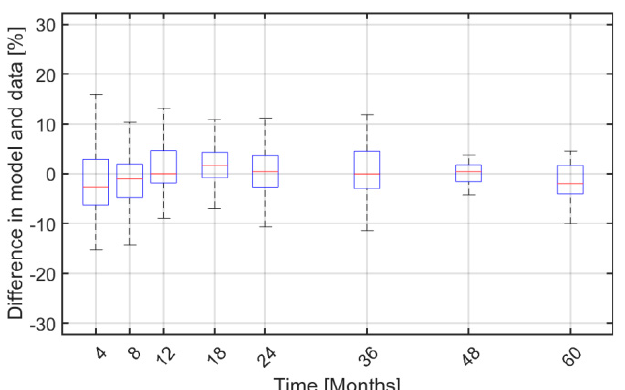
Figure 6. Boxplots of the absolute difference between the personalized JAK2 V617F allele burden data and model predictions over time—i.e., at month 4, 8, 12, 18, 24, 36, 48, and 60 after baseline.